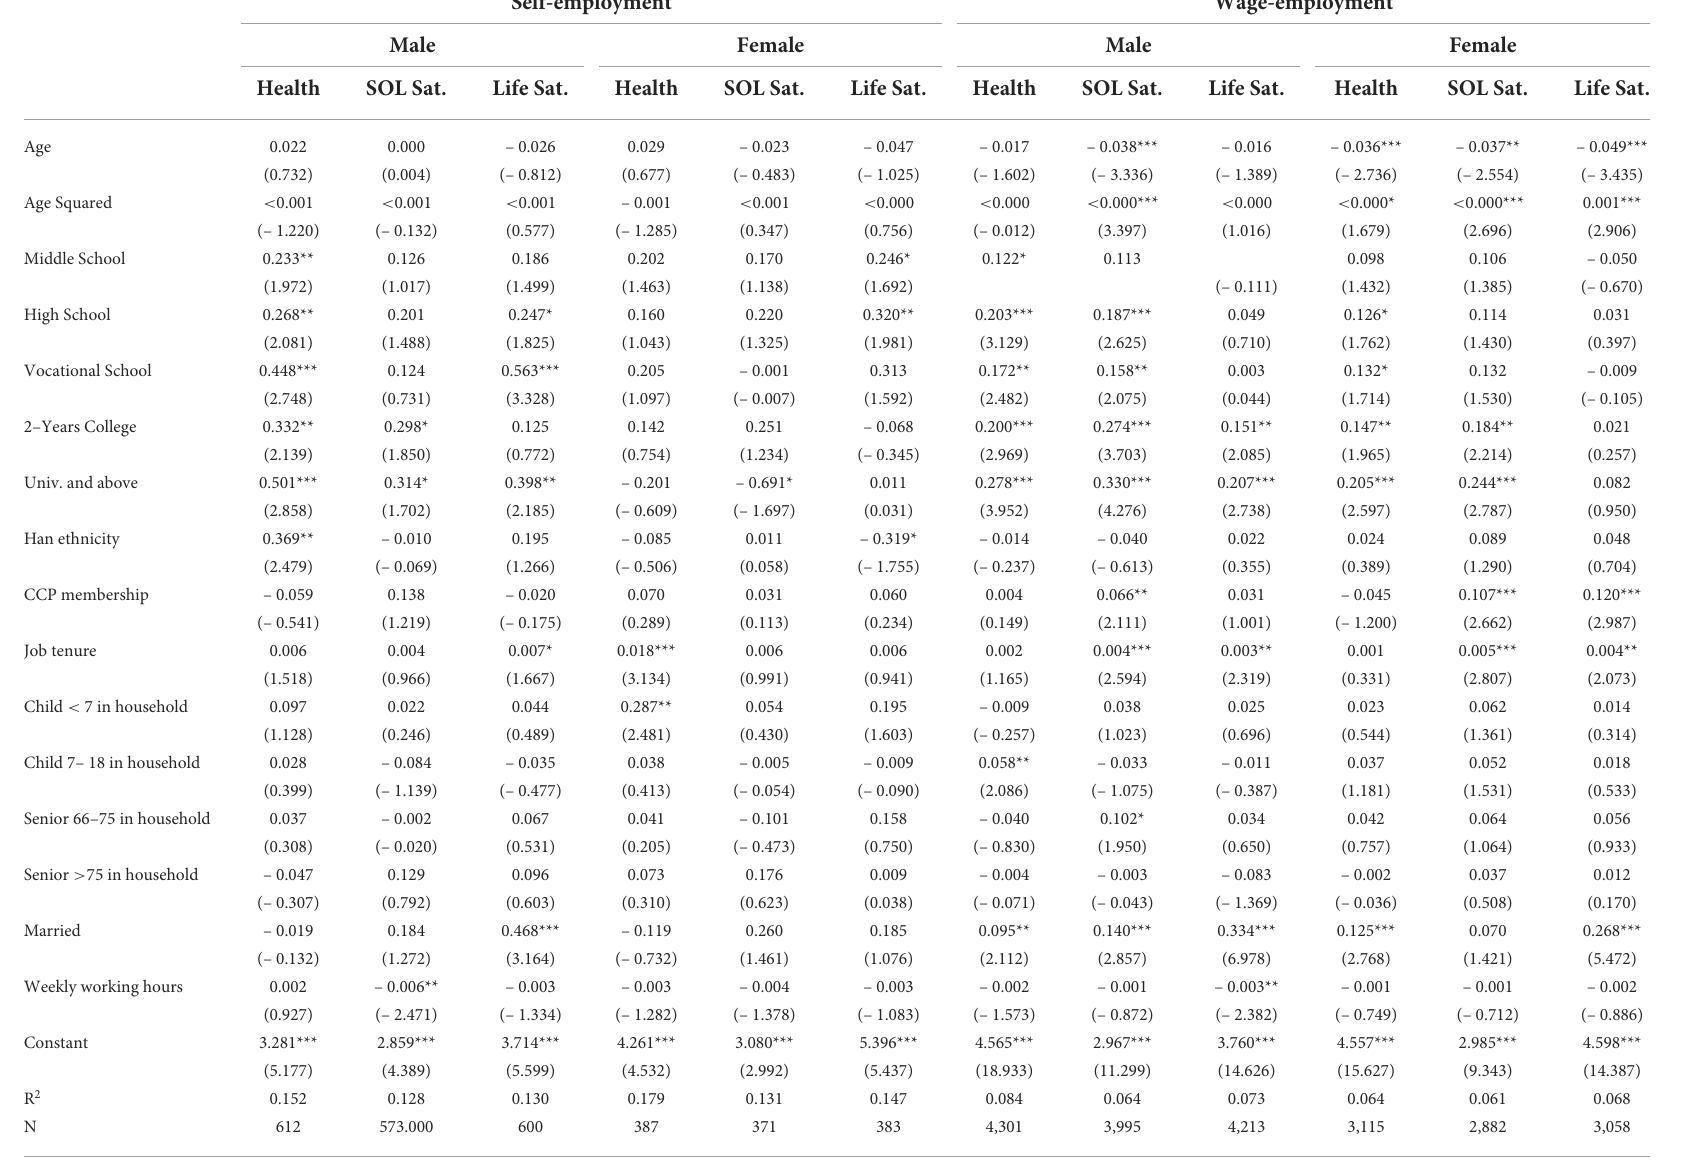
TABLE 3 Well-being regressions for self-employed and wage-employed by